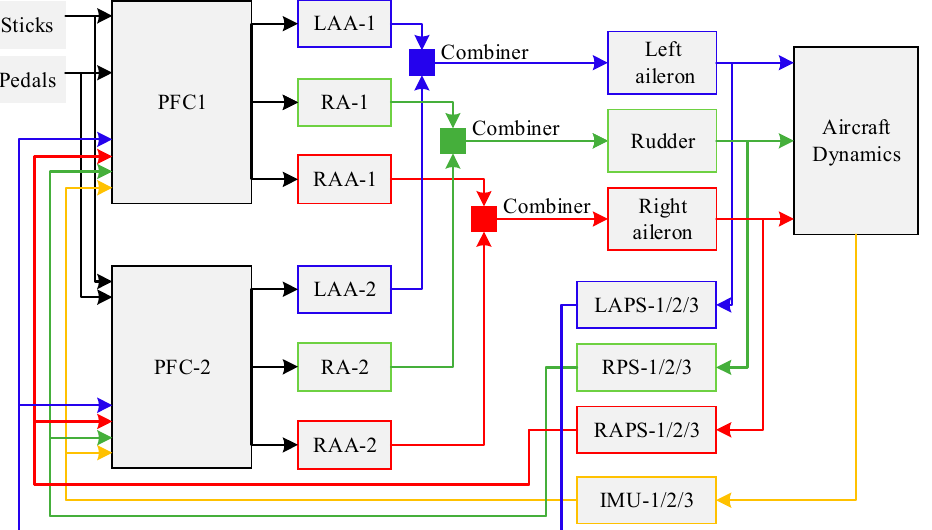
Figure 1. Architecture of the lateral-directional flight control system.